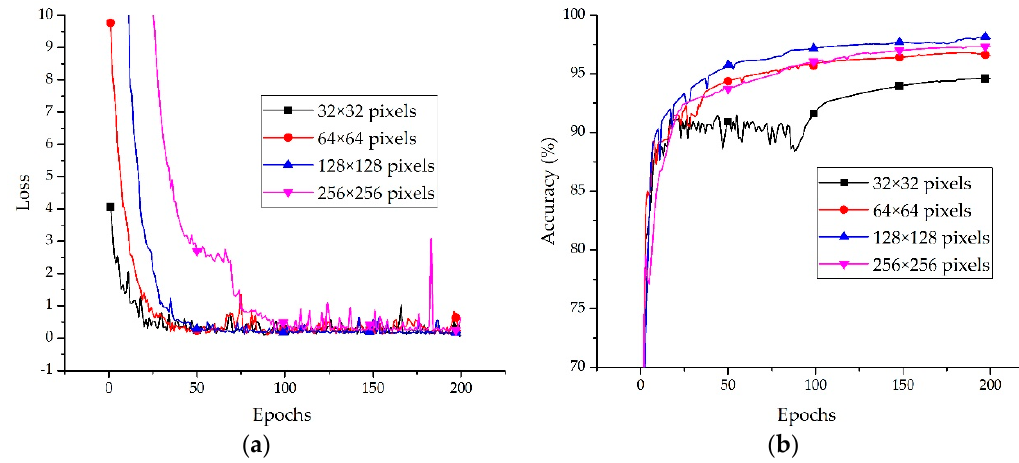
Figure 9. ( a ) Validation loss and ( b ) validation accuracy curves for four sample patch image sizes.